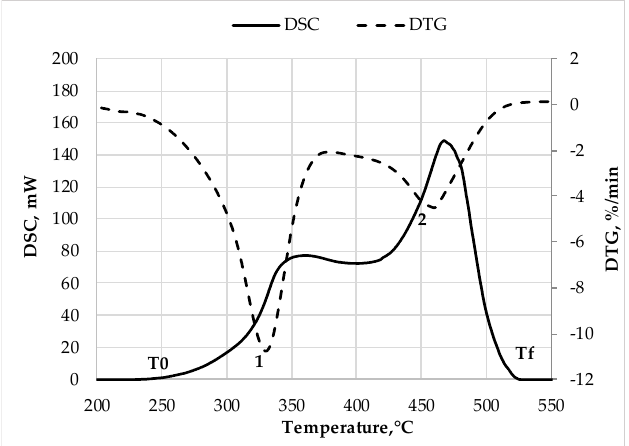
Figure 1. DTG/DSC curves of non-isothermal thermal analysis of non-treated softwood in air atmos- phere .